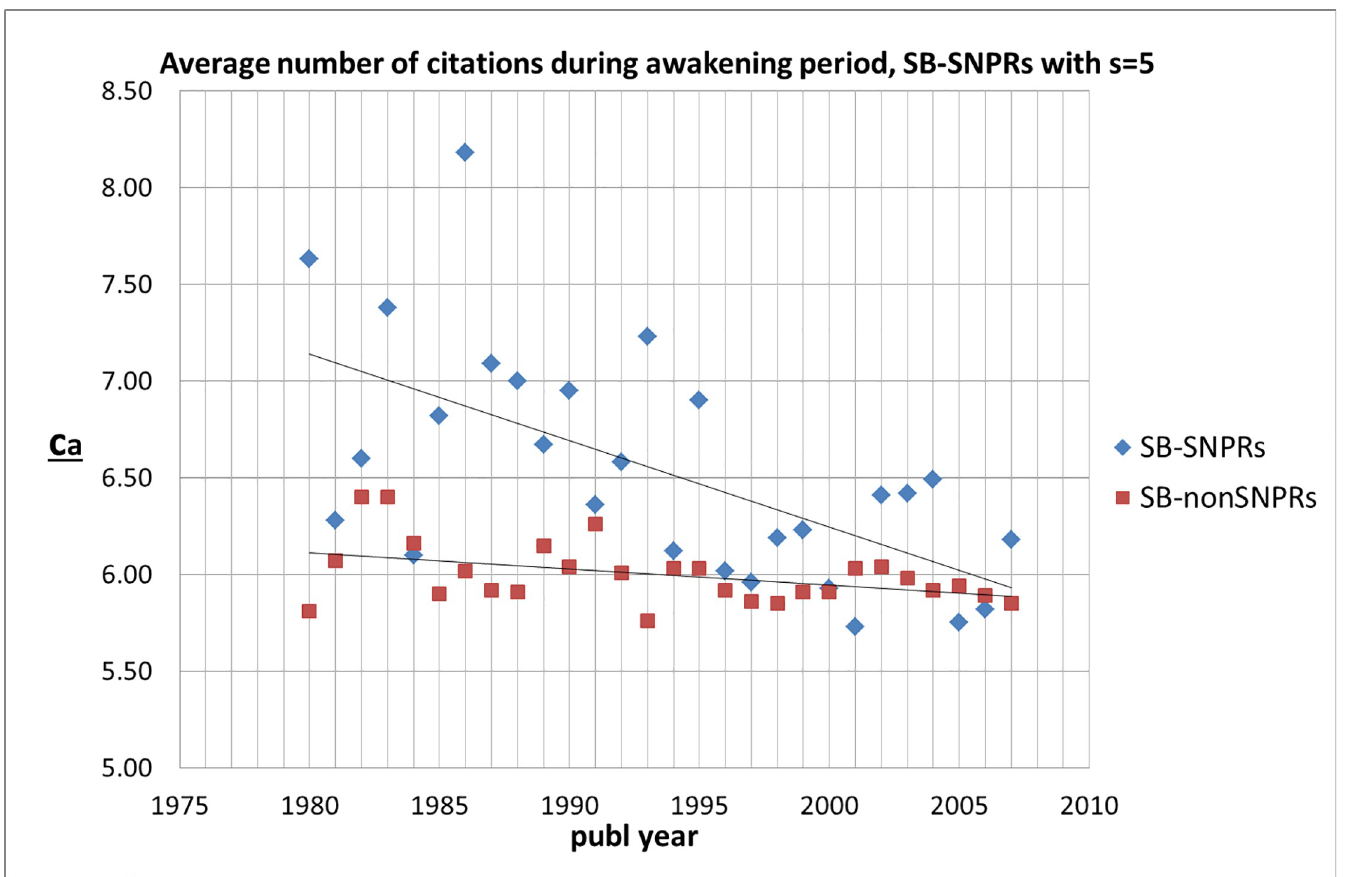
Fig 22. Average awakening citation-intensity c